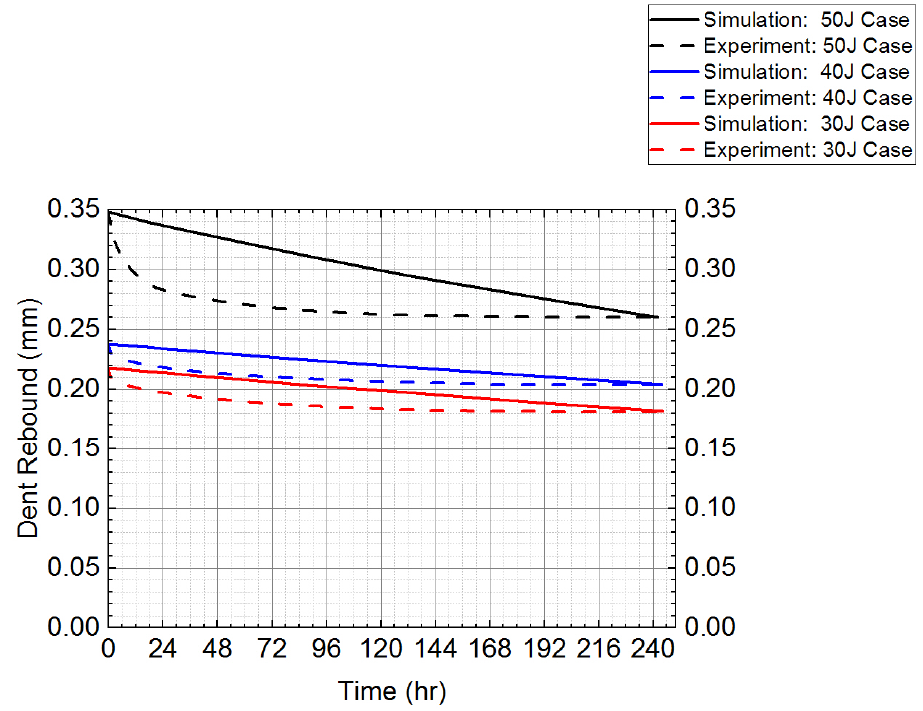
Figure 17. Comparison graph for experimental and simulated indentation rebound results.